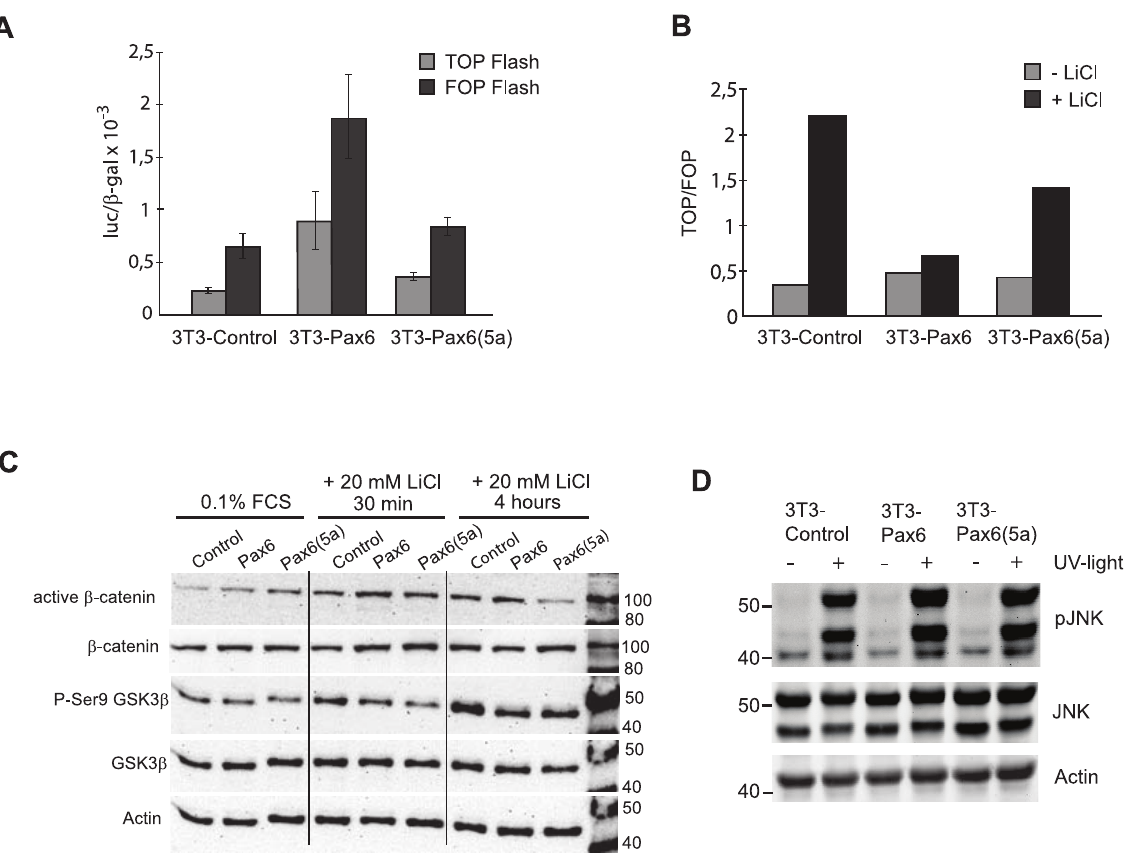
Figure 5. The FlpIn-3T3 Pax6 and Pax6(5a) cell lines display alterations in the Wnt signaling pathway compared to the FlpIn-3T3 control cell line. A, Transient transfections with the TOP and FOP reporter plasmids into the FlpIn-3T3 Control, Pax6 and Pax6(5a) cell lines, showing basal (background) luc/ b -gal activities. B, Calculations of TOP/FOP ratios as measures for Wnt signaling pathway response after transient transfections and LiCl stimulation (20 mM) for 20 hours before harvesting of the three FlpIn-3T3 cell lines. C, Western blot of FlpIn-3T3 control, -Pax6 and -Pax6(5a) cell lines serum starved for about 2 days before they were stimulated with LiCl (20 mM) and harvested after 30 minutes and after 4 hours. Antibody against active b -catenin was first used and images were developed. The membrane was then stripped and antibodies against total b -catenin and actin were used. Likewise, an antibody recognizing phosphorylated serine 9 in GSK3- b (inactivated) was first used, before antibodies against total amount of GSK3- b and actin was applied to the same membrane. Results are representative of two biological replicates. D, The ability of the FlpIn-3T3 cell lines to phosphorylate JNK was investigated by Western blot after UV stimulation. Similar results were observed in three biological replicates.